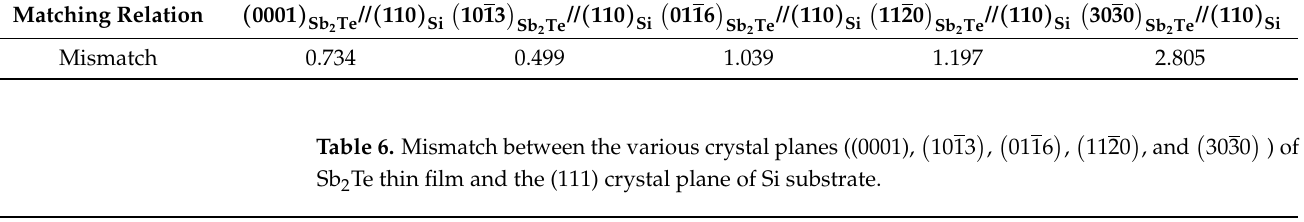
(cid:0) (cid:1) (cid:0) (cid:1) (cid:0) (cid:1) (cid:0) (cid:1) 1013 , 0116 , 1120 , and 3030 ) of